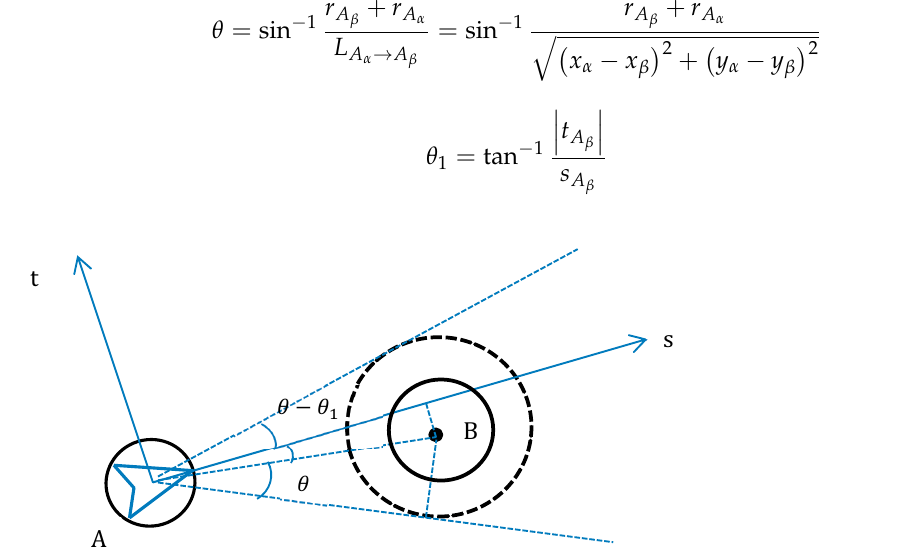
Figure 10. Angle of deflection.